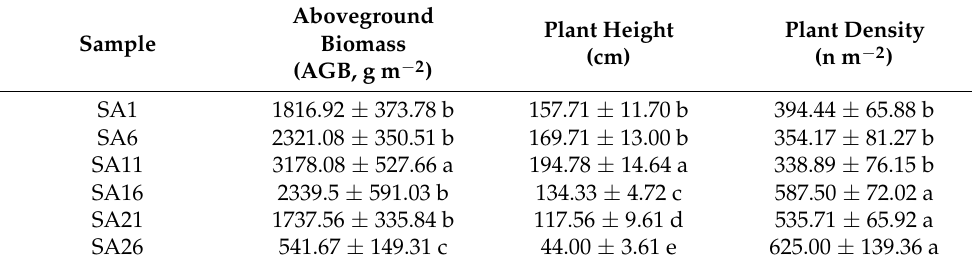
Table 1. Characteristics of plants of different invasive